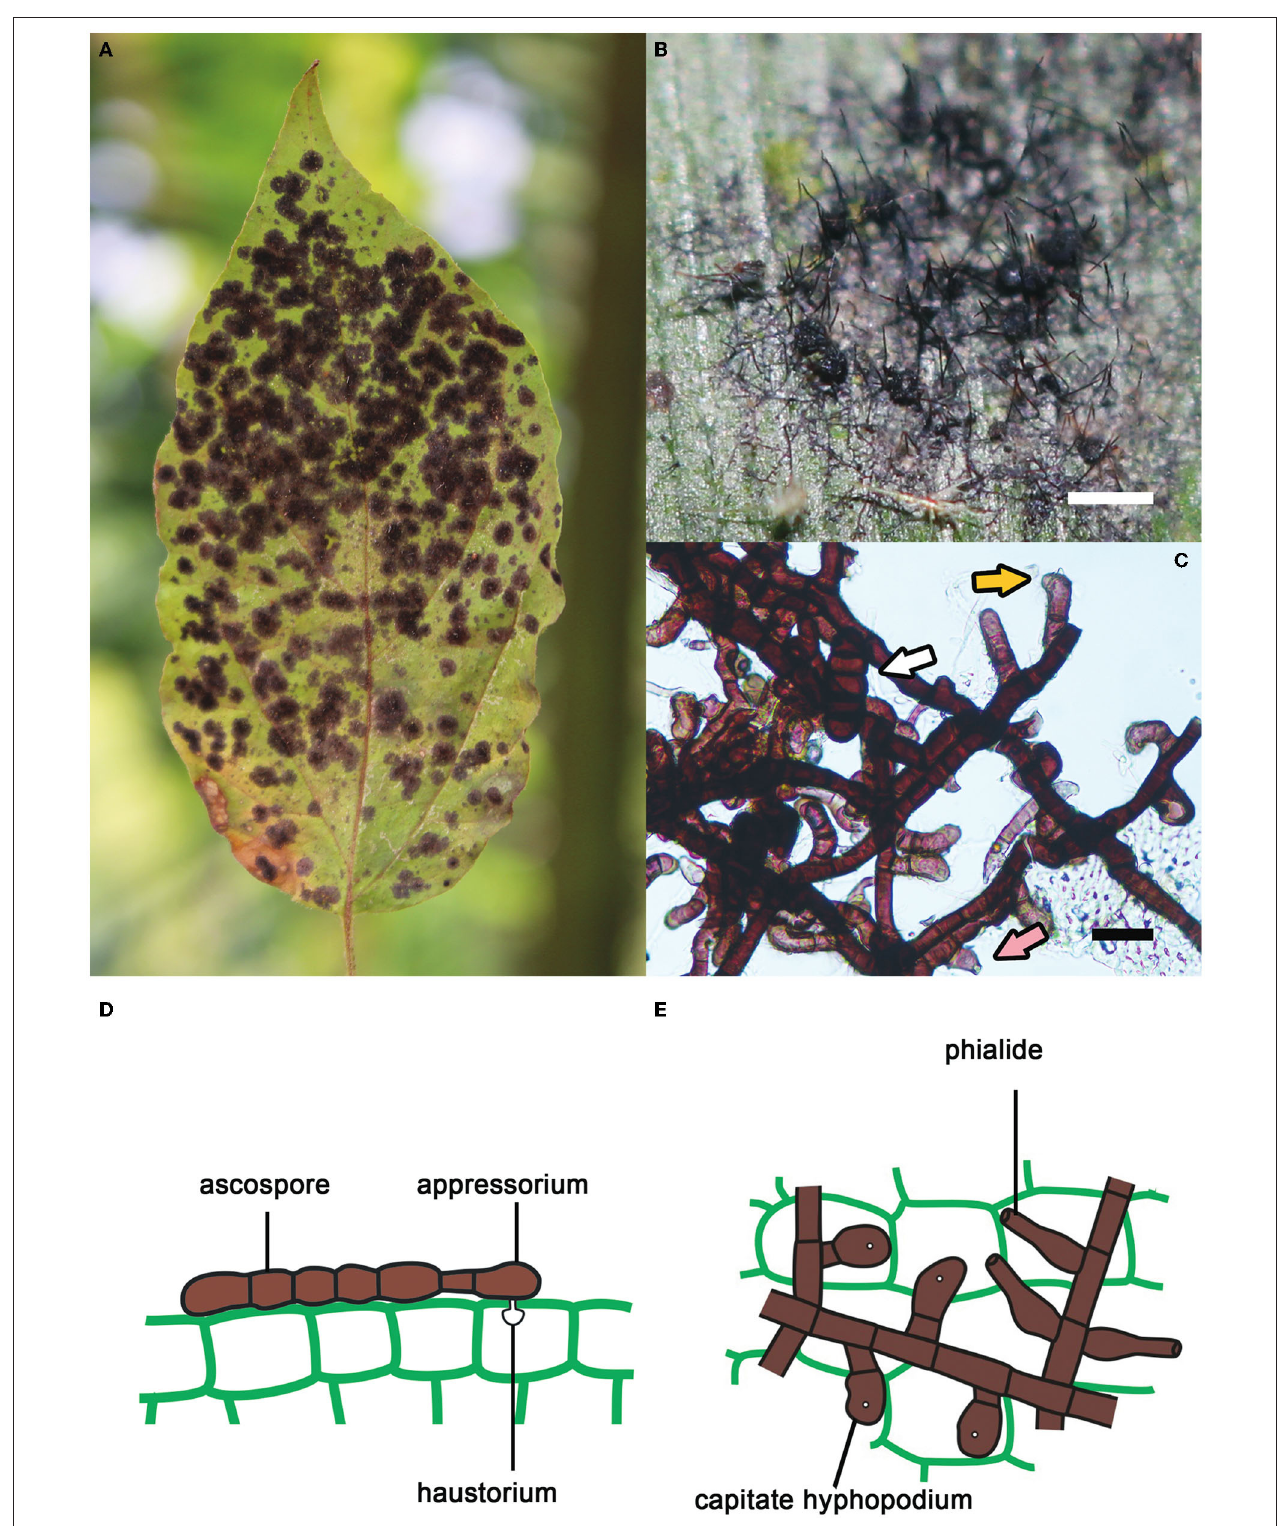
FIGURE 1 | Key features of species of Meliolales. (A) Black colonies of Meliola clerodendricola on a leaf of Clerodendrum sp. (B) Superficial hyphae, perithecia and setae of Meliola sp. on a leaf of Olyra latifolia . Bar, 1 mm. (C) Hyphae of Meliola mangiferae with capitate hyphopodia (yellow arrow), a phialide (pink arrow) and a septate ascospore (white arrow). Bar, 20 µ m. (D,E) Schematic drawings of cells of Meliola spp. (D) Ascospore on the surface of host tissue with a capitate hyphopodium including an appressorium penetrating the wall of the epidermis. (E) Hyphae with capitate hyphopodia and phialides.